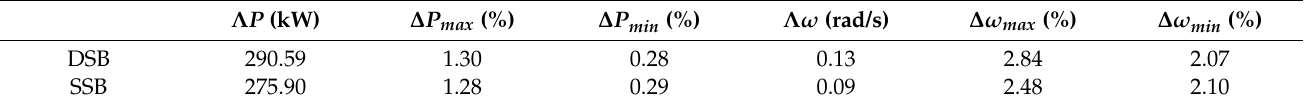
Figure 12. Influence of sliding Binning mode on wind–power curve. ( a ) wind–power curves obtained by selecting DSB mode using three Quartile-based methods; ( b ) wind–power curves obtained by selecting DSB mode using three PauTa-based methods; ( c ) wind–power curves obtained by selecting DSB mode using three KDE-based methods; ( d ) wind–power curves obtained by selecting SSB mode using three Quartile-based methods; ( e ) wind–power curves obtained by selecting SSB mode using three PauTa-based methods; ( f ) wind–power curves obtained by selecting SSB mode using three KDE-based methods. Table 4. Indicators of two kinds of sliding Binning